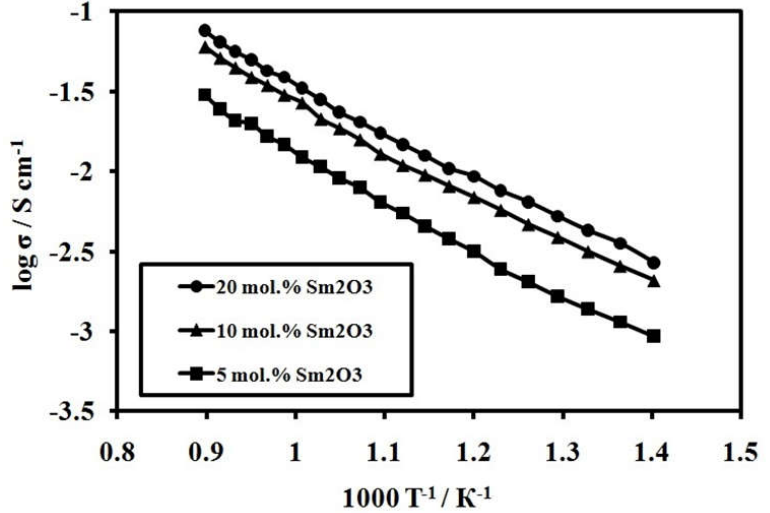
Figure 5. Temperature dependence for specific electrical conductivity of (CeO 2 ) 0.95 (Sm 2 O 3 ) 0.05 ( ■ ); (CeO 2 ) 0.90 (Sm 2 O 3 ) 0.10 ( ▲ ) and (CeO 2 ) 0.80 (Sm 2 O 3 ) 0.20 (●) ceramics samples.